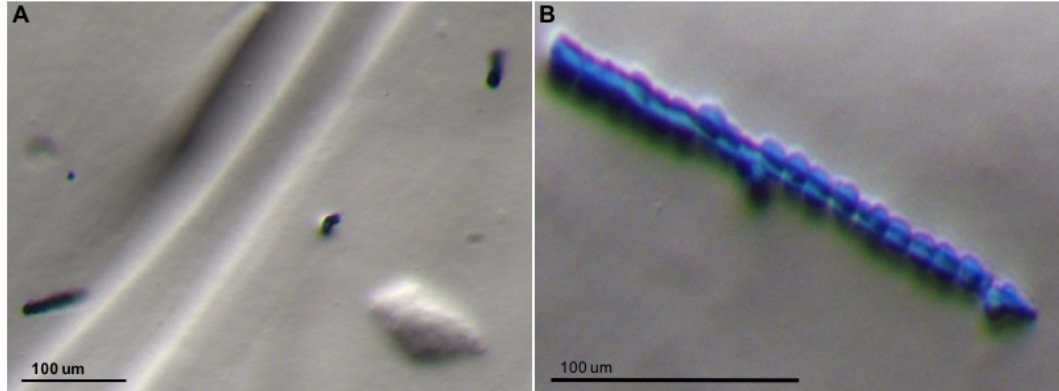
Figure 1. Stylet sheaths deposited by adult D. citri feeding on semi-solid agarose diets. D. citri stylet sheaths recovered from an artificial diet chamber containing five adult D. citri . Diets were removed from the chamber and post-stained with colloidal blue and imaged using a Leica M205 stereo microscope at low magnification ( A ) and higher magnification ( B ).